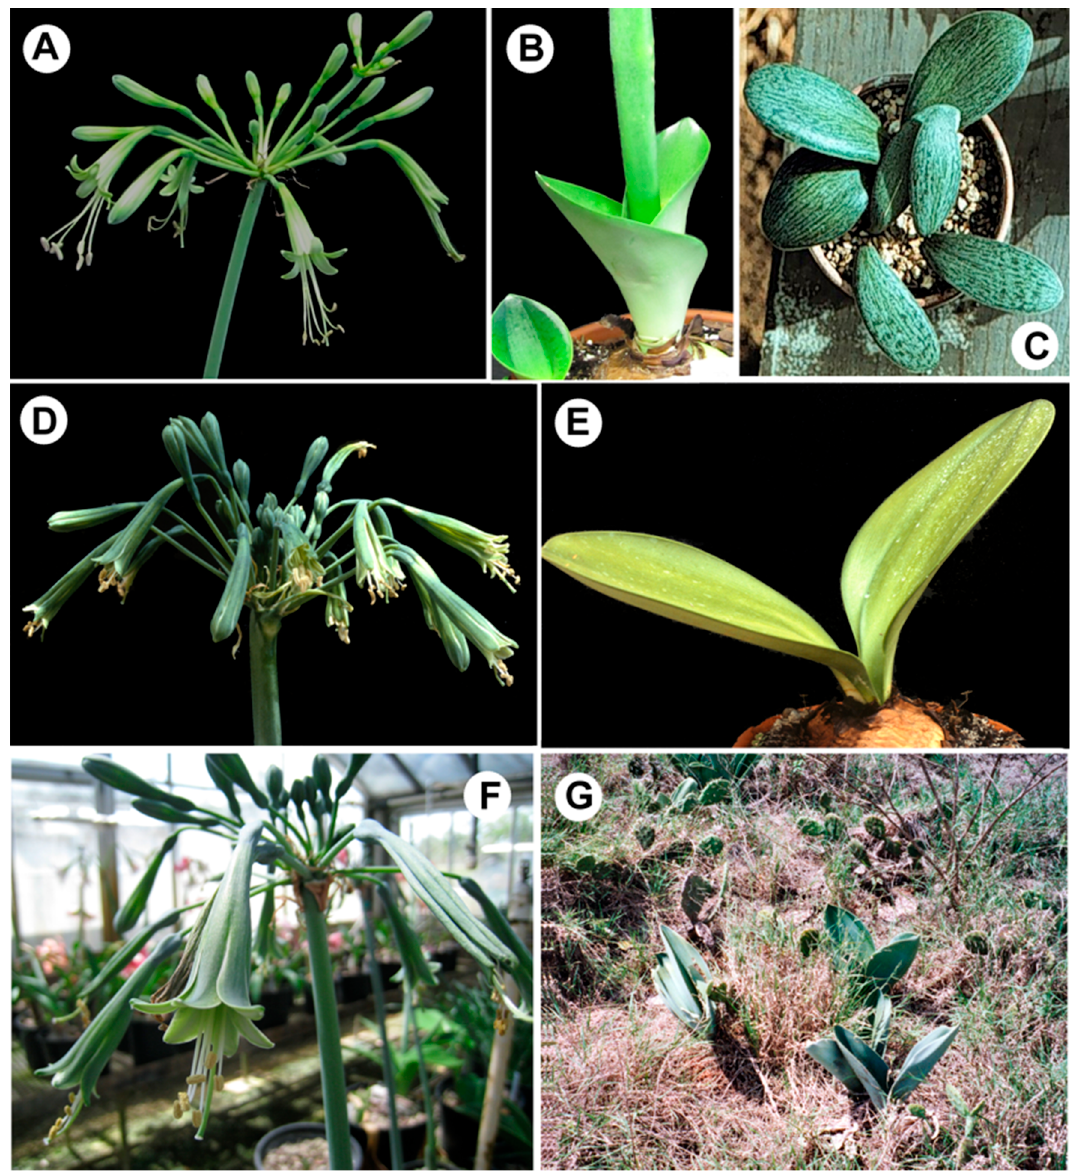
Figure 1. Rauhia species investigated in this study. ( A – C ). R. decora . ( A ). Flowers. ( B ). Emerging leaves with induplicate vernation that form a funnel-like structure, putatively a device for channeling moisture to the bulb. ( C ). Juvenile leaves showing tessellation. ( D , E ). R. multiflora . ( D ). Flowers. ( E ). Fully developed leaves. ( F , G ). R. staminosa . ( F ). Flowers. ( G ). In natural habitat, Amazonas